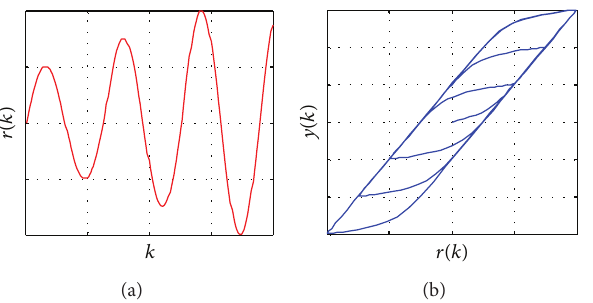
Figure 1: Input 𝑟(𝑘) (a) and the corresponding output 𝑦(𝑘) map (b) trajectories of the parametric hysteresis